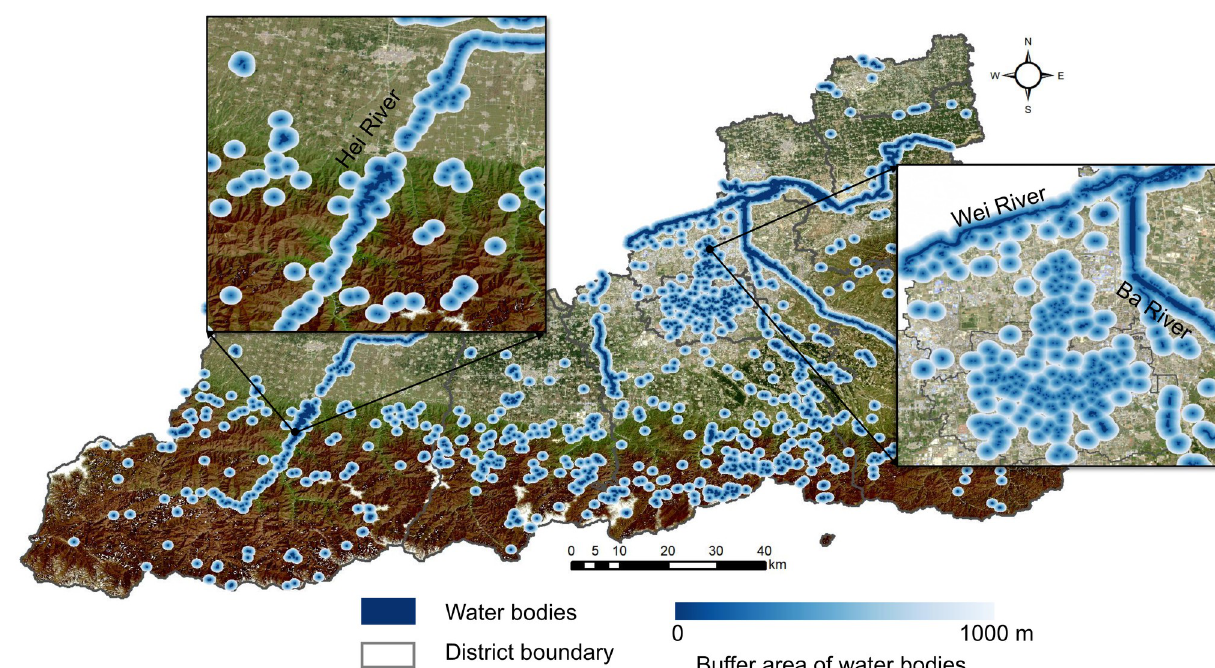
Fig 4. Buffer analysis for water bodies in Xi’an City. The figure was produced in ArcGIS 10.8 (ESRI, Redlands, CA, USA) using shape files representing Xi’an City which were obtained from the National Catalogue Service For Geographic Information of China (https://www.webmap.cn/ mapDataAction.do?method=forw&resType=5&storeId=2).